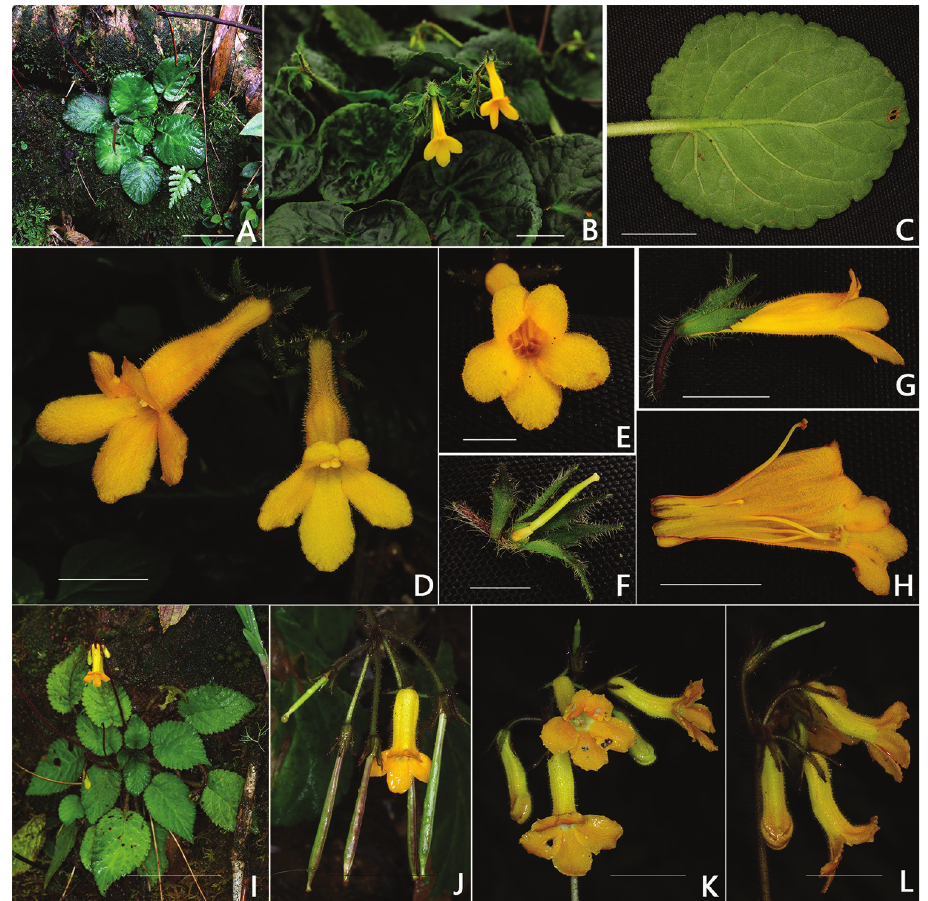
Figure 2. Oreocharis longituba W.H.Chen, Q.H.Nguyen & Y.M.Shui, sp. nov. ( A–H ) and its most simi- lar species, Oreocharis hirsuta Barnett ( I–L ) A Habitat B Mature plant C Abaxial leaf surface D, E Front view of flower F Pistil with immature stigma, disc and calyx G Lateral view of flower H Opened corolla I Mature plant J Flower and fruits K Front view of flowers L Side view of flowers. Scale bars: A, I =5 cm, D–H = 1 cm; J, K, L = 2 cm. A–H photographs by Yu-Min Shui, I–L by Preecha Karaket of Middleton et al. 4550